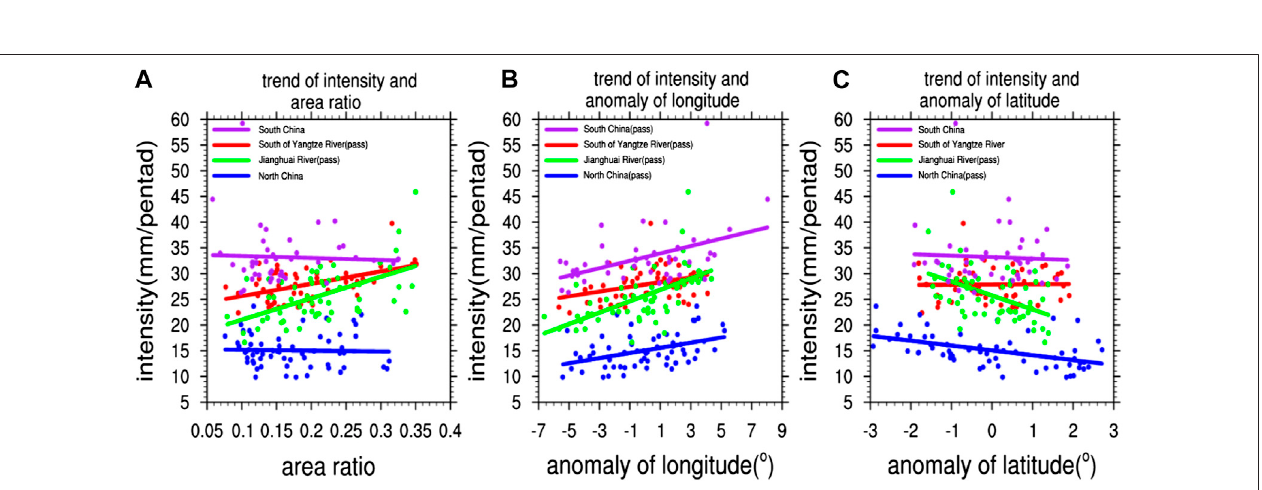
FIGURE 4 | Scatter plots of intensity (unit: mm per pentad) with area ratio (A) , anomalous longitude (unit: ° ) (B), and latitude (unit: ° ) (C) of RPEPs in four cluster regions. Purple dot, red dot, green dot, and blue dot with their fi tting lines represent SC, SYR, JHR, and NC, respectively; “ pass ” in the legend means that the fi tting line has a signi fi cant trend at the 95% con fi dence